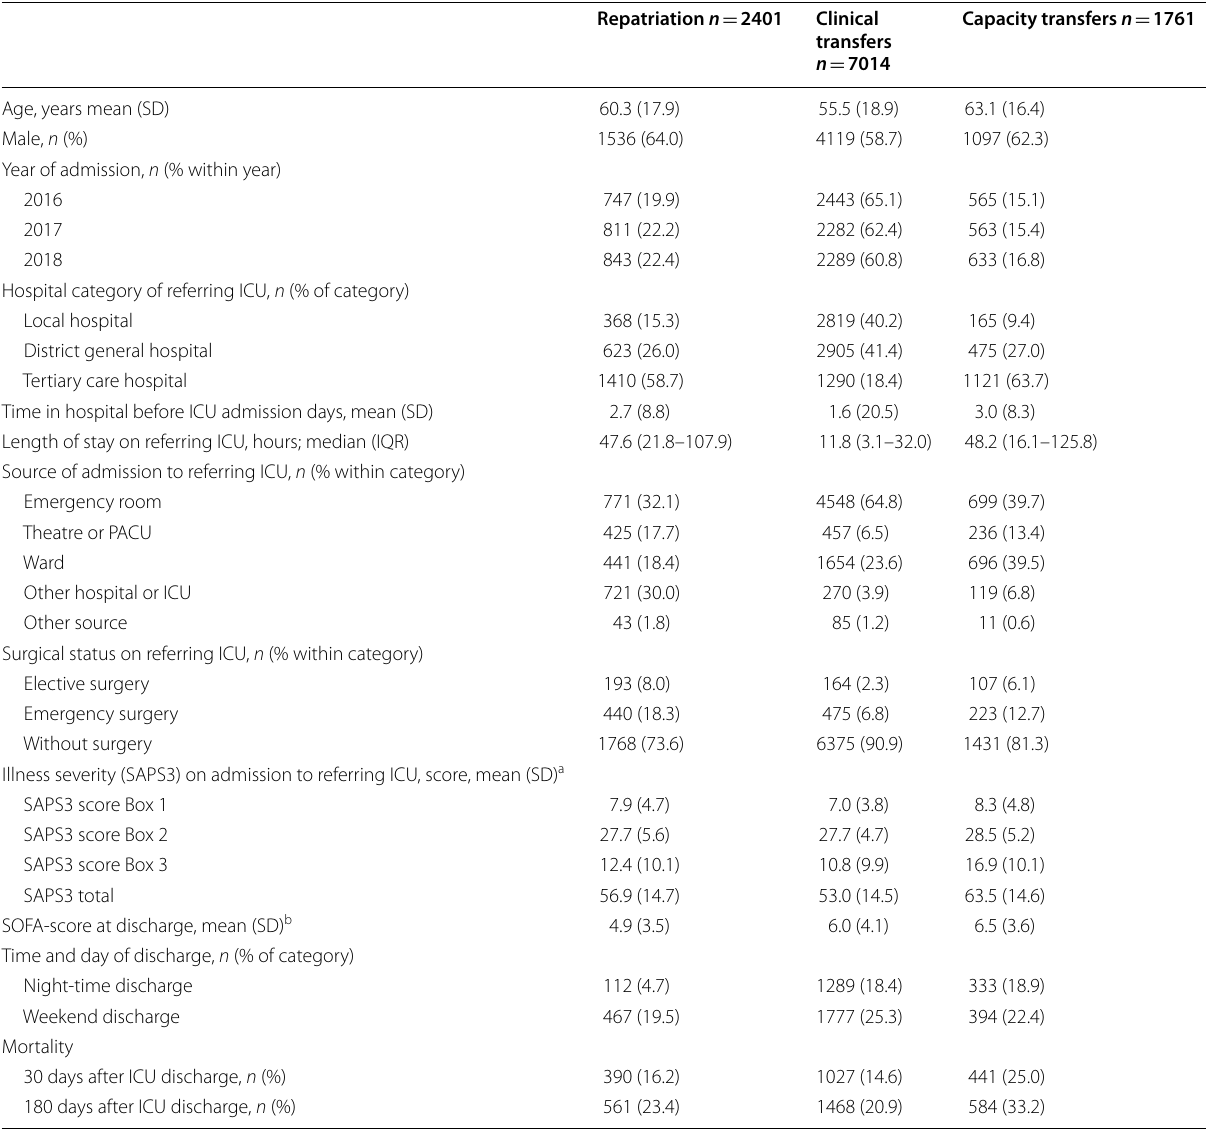
a See Methods for SAPS3 boxes